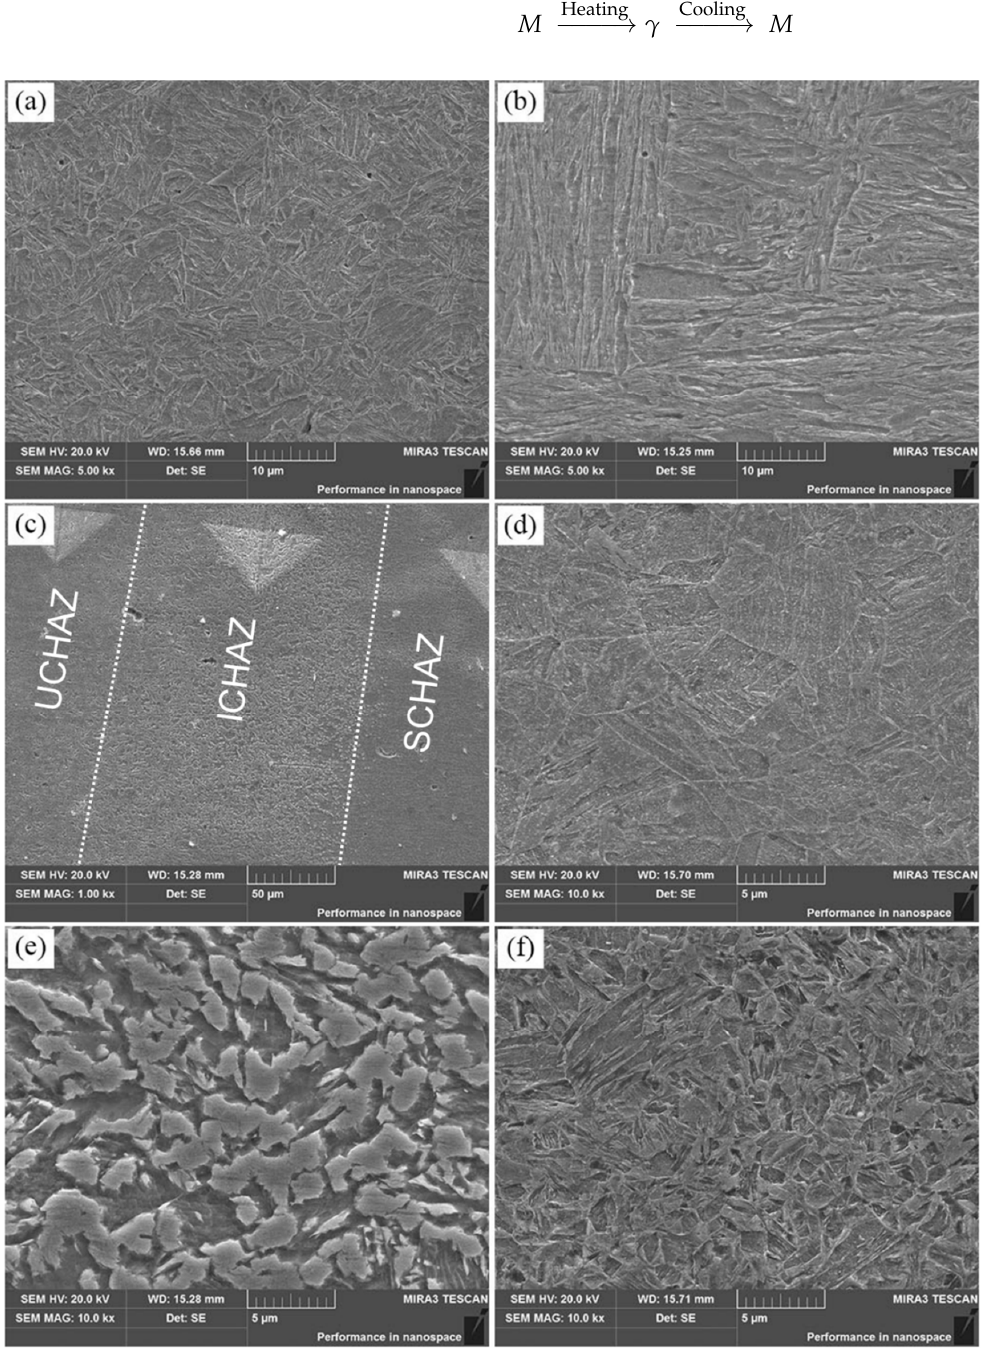
Figure 7. SEM micrographs showing microstructure of ( a ) BM, ( b ) NZ, ( c ) HAZ, ( d ) SCHAZ, ( e ) ICHAZ, ( f ) UCHAZ for RSW on MS1400 steel.